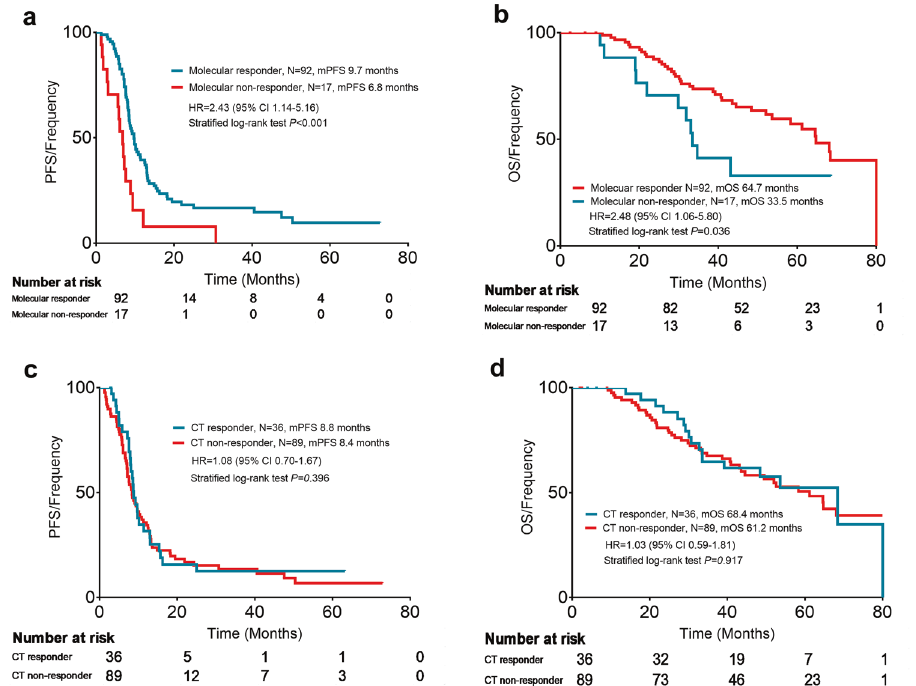
Fig. 4 Survival analysis based on early response according to mTBI or CT scan. a PFS analysis based on early response according to the mTBI. b OS analysis based on early response according to the mTBI. c PFS analysis based on early response according to CT scan. d OS analysis based on early response according to CT scans. CT computed tomography, mTBI molecular tumor burden index, PFS progression-free survival, OS overall survival, HR hazard ratio, CI con fi dence